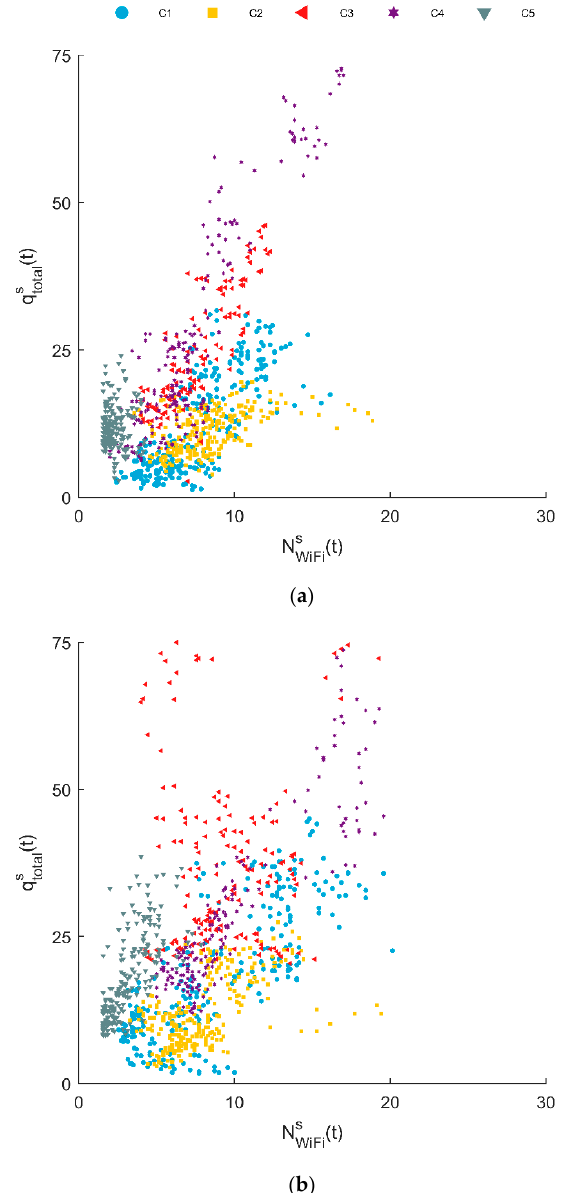
Figure 5. The relation between the Wi-Fi counts and the flow rate at sensor locations C1–C5, for ( a